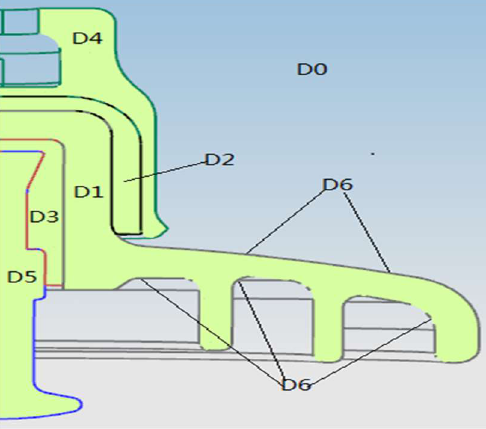
Figure 4. Disc insulator for numerical simulation.